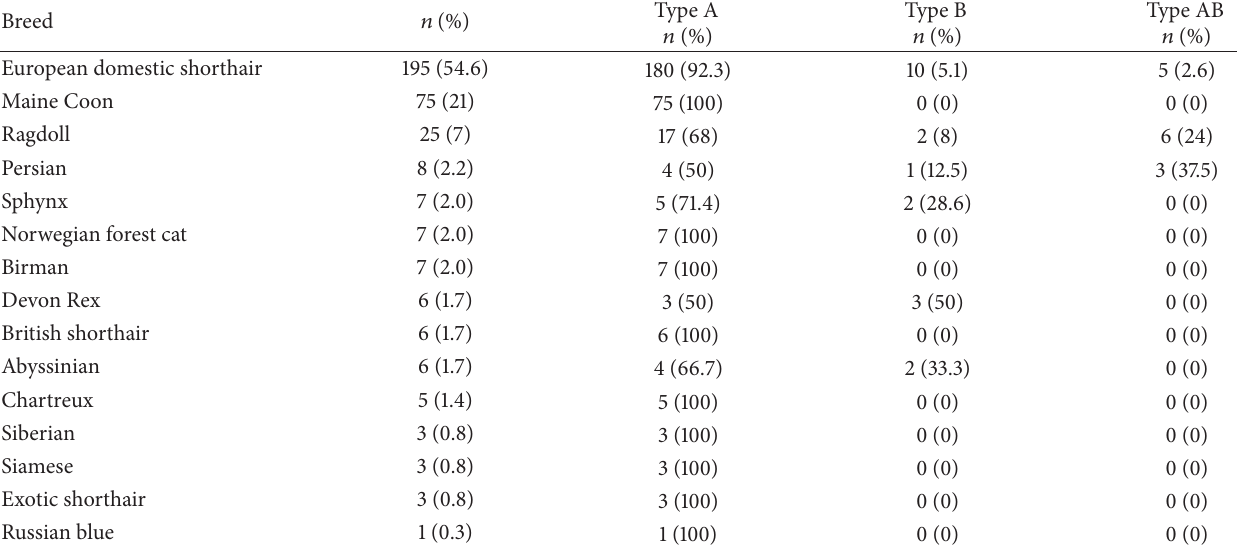
Table 1: Breed and blood type in 357 cats evaluated as potential blood donors at two Italian university blood banks. Breed 𝑛